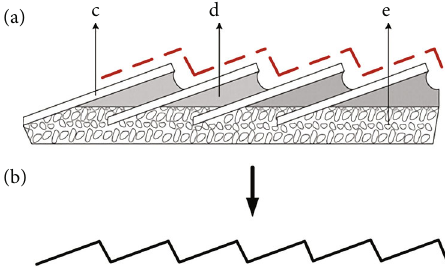
Figure 20: Extraction of the fi ssure model: (a) fi ssure structure: C- scale, D-mucus, and e-epidermis, and (b) chute structure